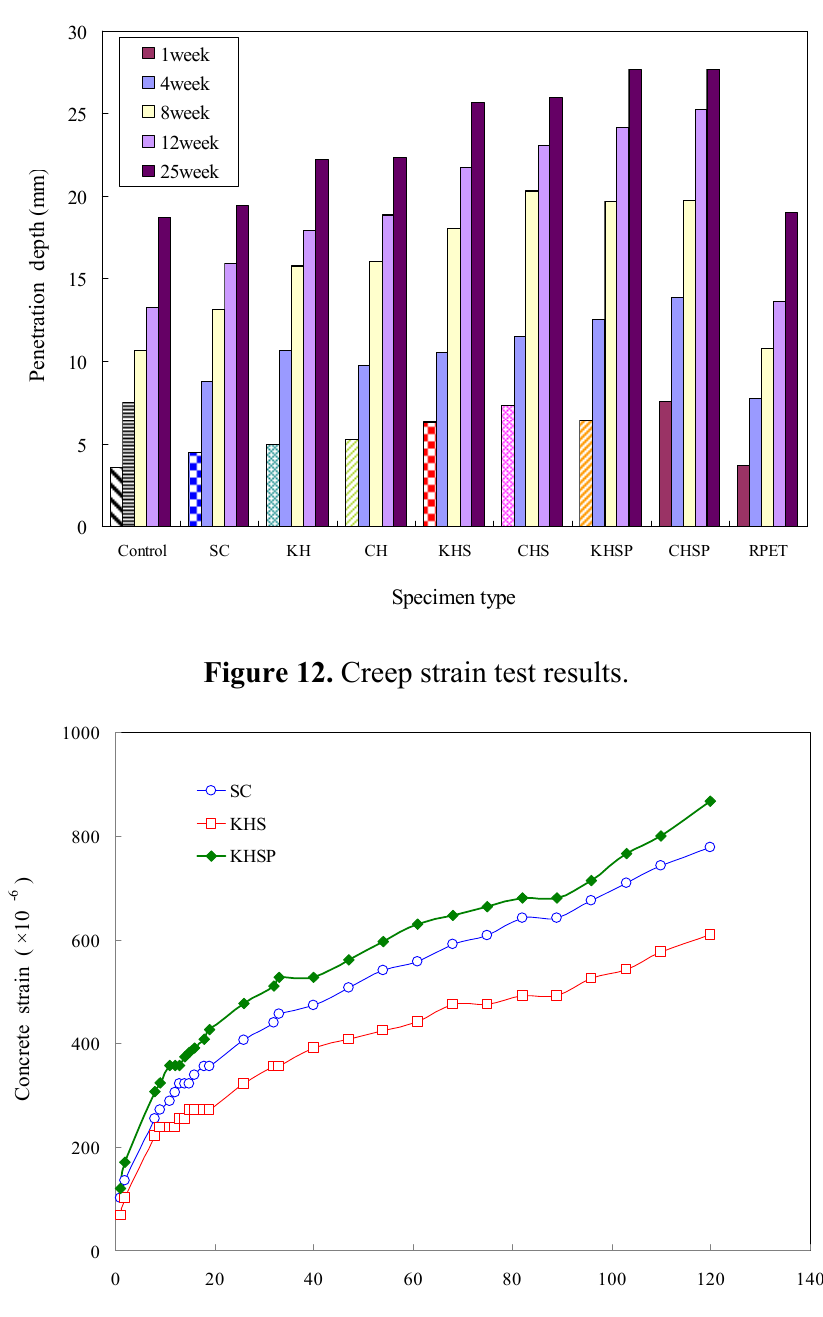
Figure 11. Carbonation depth results.